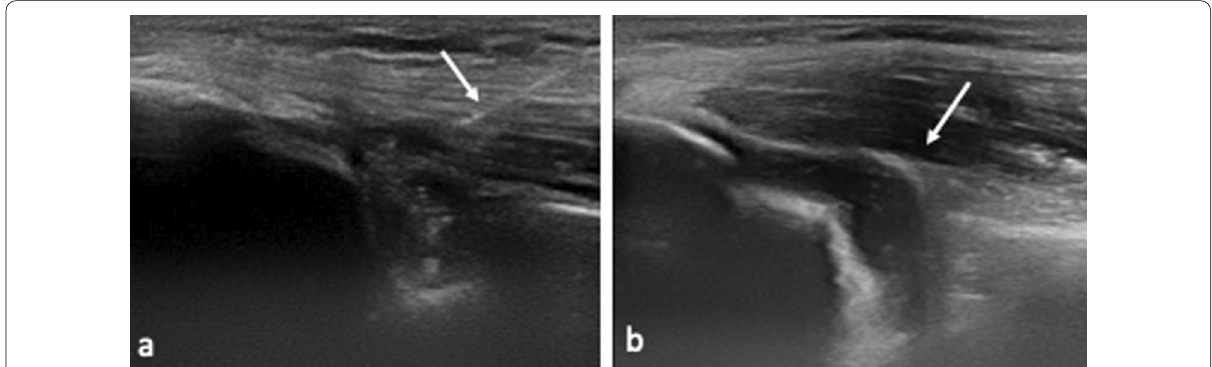
Fig. 3 In-plane US-guided intra-articular injection ( a ). The spinal needle is clearly visible as a hyperechoic linear image, as the tip (white arrow) approaches the designed target. The posterior articular recess (asterisk) expands as contrast agent is injected, becoming visible as a hypoechoic sac, confirming the appropriateness of the procedure ( b )